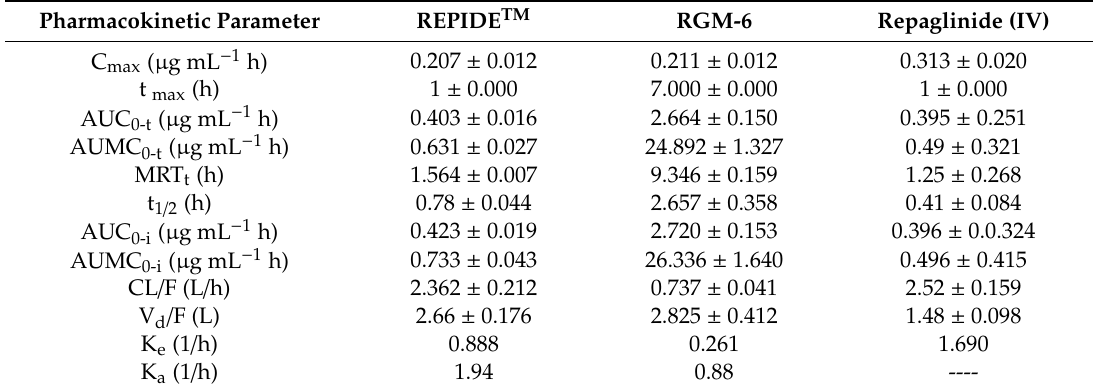
Table 5. Pharmacokinetic parameters for marketed (Repide) and test (RGM-6) formulations.